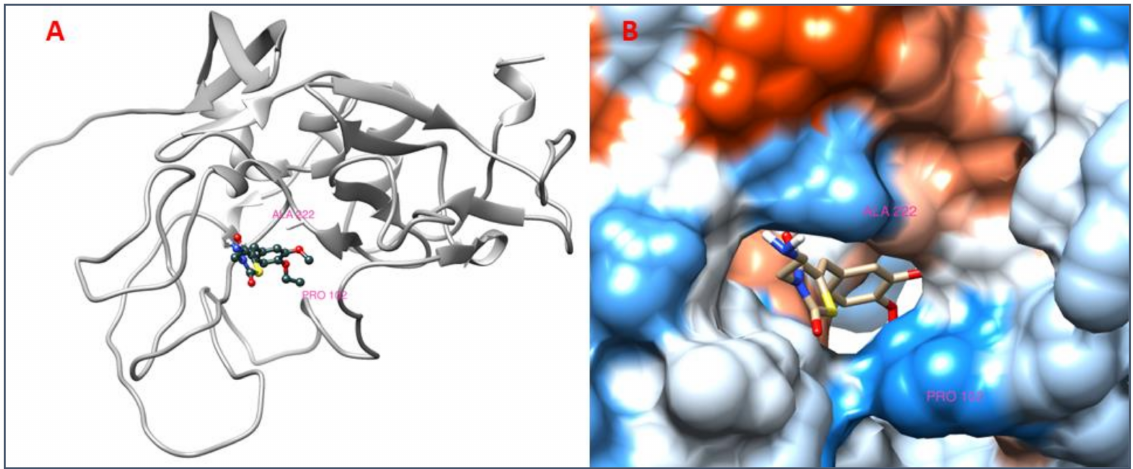
Figure 7. ( A ) 3D interaction of [(5Z)-5-[(4-ethoxy-3-methoxyphenyl)methylidene]-2,4-dioxo-1,3-thiazolidin-3-yl]ethylazanium and HCV E2 protein having binding affinity − 12.4; ( B ) Surface representation of interaction.